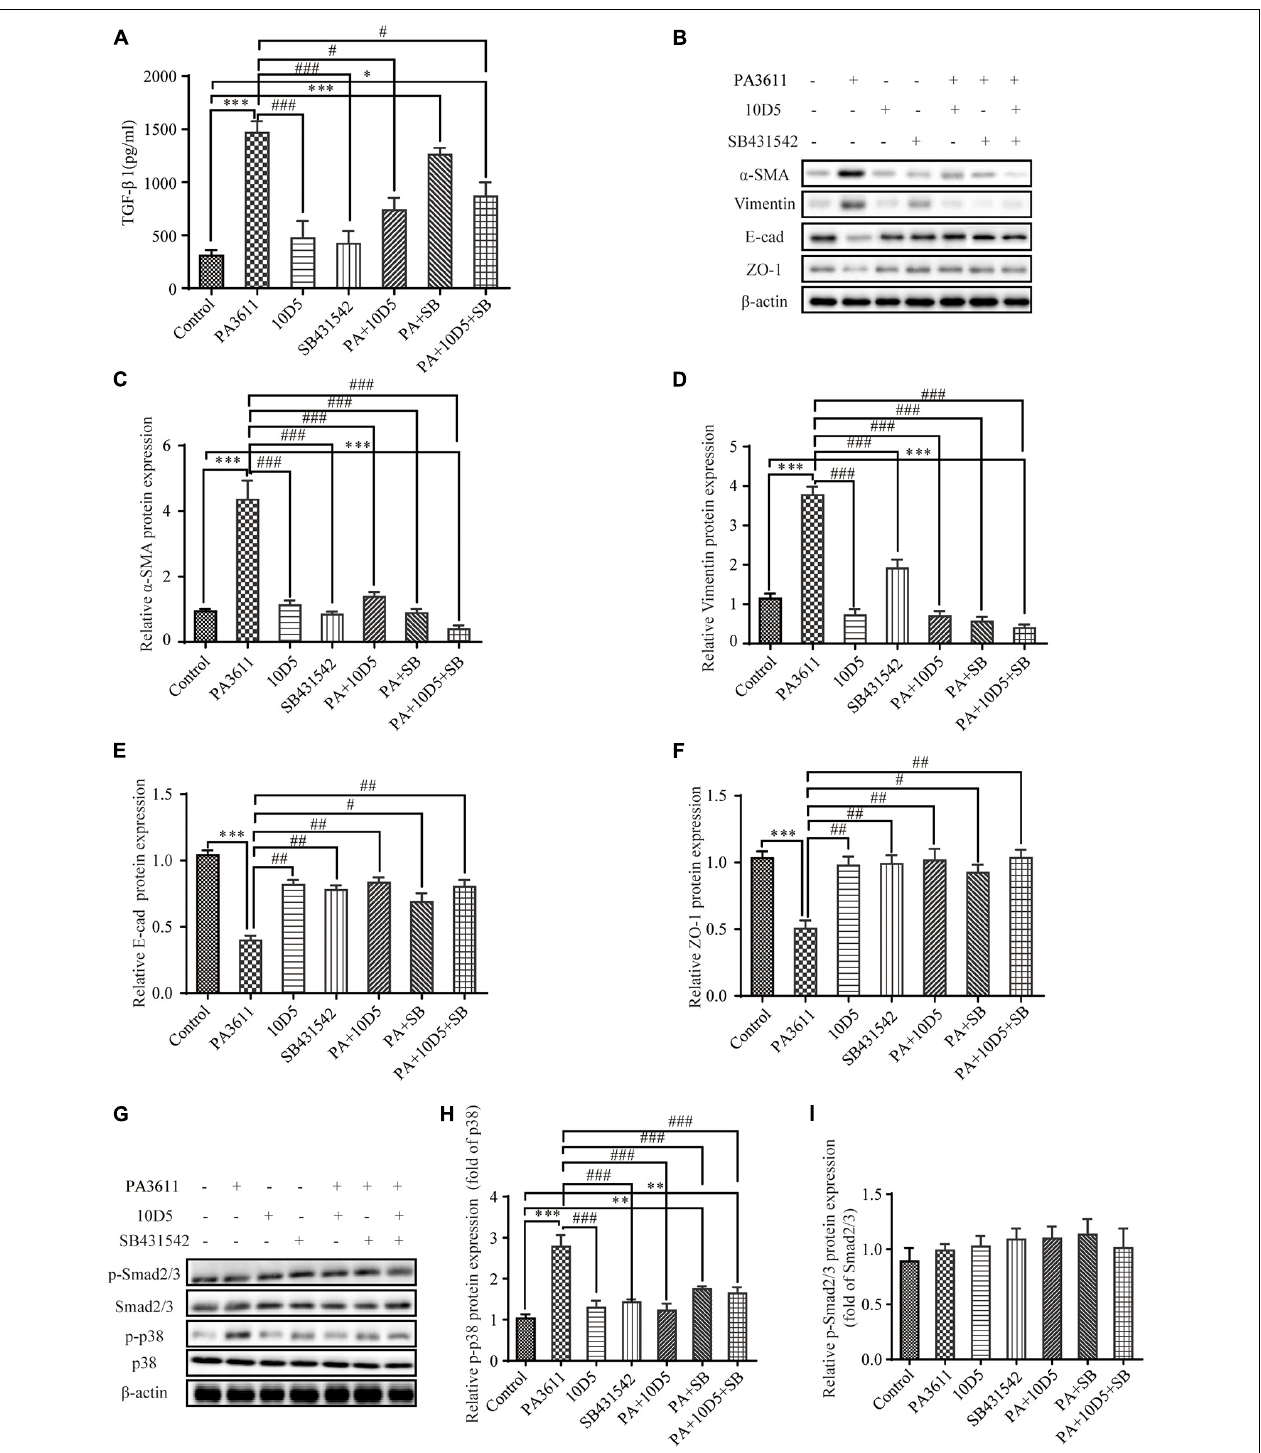
FIGURE 5 | PA3611 stimulated TGF- β 1 expression and induced EMT, which could be inhibited by blocking integrin α v β 6. 16HBE14o- cells were pretreated with the integrin α v β 6-blocking antibody 10D5 (10 µ M) or a specific inhibitor of TGF- β 1-Smad2/3 signaling, SB431542 (10 µ M), for 2 h prior to incubation with PA3611 (10 µ g/mL) for 48 h. The TGF- β 1 levels in cell culture supernatants were evaluated by ELISA (A) . EMT-related proteins (B–F) and signaling pathway proteins (G–I) were detected using Western blotting. The results are representative of three independent experiments, and the data are presented as the means ± SD. ∗ P < 0.05, ∗∗ P < 0.01, ∗∗∗ P < 0.001, vs. the control group; # P < 0.05, ## P < 0.01, ### P < 0.001, vs. the PA3611 group.